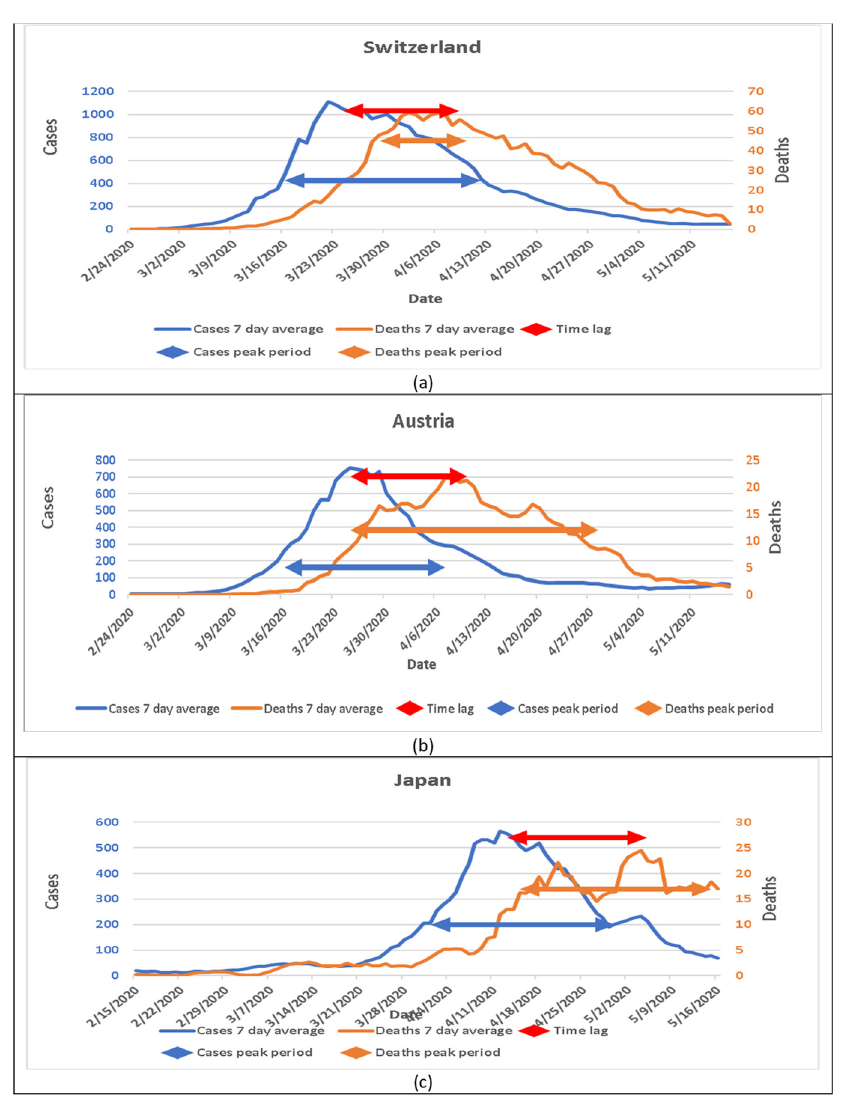
Figure 2. Patterns of cases and deaths from COVID-19 in three countries. ( a ) New cases and deaths in Switzerland; ( b ) New cases and deaths in Austria; ( c ) New cases and deaths in Japan.